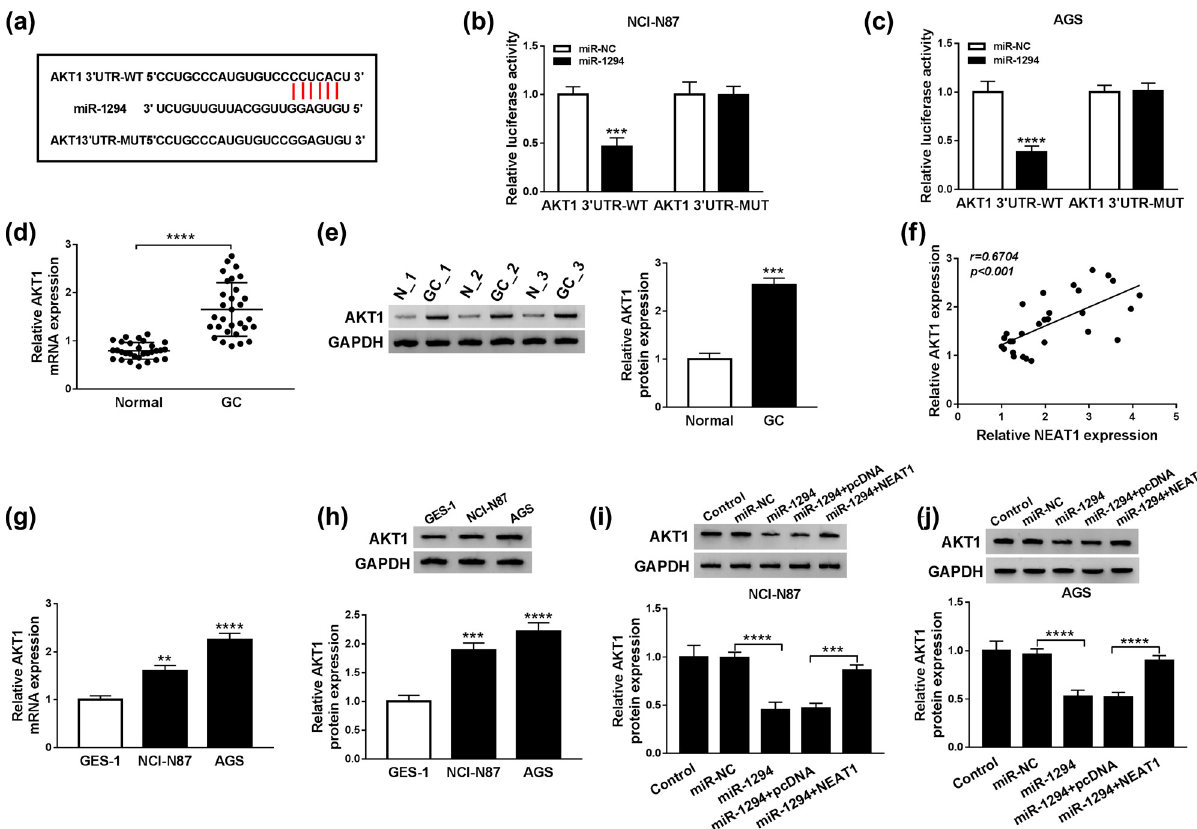
Figure 4: NEAT1 elevated the expression of AKT1 by sponging miR - 1294. ( a ) Starbase v2.0 was used to predict the targets of miR - 1294. ( b and c ) Dual - luciferase reporter assay was used to verify the relation of miR - 1294 and AKT1. ( d and e ) The expression of AKT1 in GC tissues was detected by qRT - PCR and Western blot. ( f ) Spearman ’ s correlation coe ffi cient was used to analyze the relation between miR - 1294 and AKT1 in GC tissues. ( g and h ) AKT1 expression in GC cells was determined by qRT - PCR and Western blot. ( i and j ) Western blot was utilized to measure AKT1 protein expression in NCI - N87 and AGS cells transfected with miR - 1294, miR - 1294 + NEAT1, and relative controls. ** P < 0.01, *** P < 0.001, **** P <